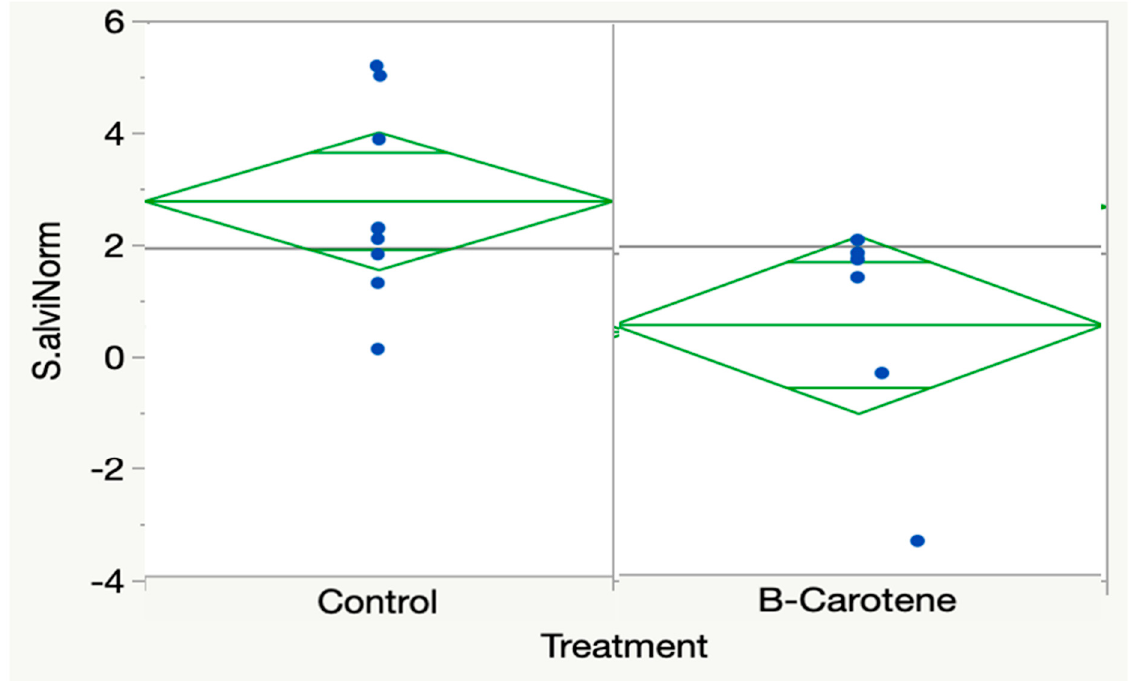
Figure 5. One-way analysis of a honey bee gut symbiont in bees fed beta-carotene vs. the control. Normalized Cq values of a cup study with 6 replicates/cup per treatment or 10 replicates/cup for the control. Treatments were supplemented with sugar water at 2000 ppm. A larger value indicates increased detection of the honey bee gut symbiont S. alvi . The diamond tips represent the 95% confidence intervals for the ANOVA, with the mean designated with the middle horizontal line across each diamond.